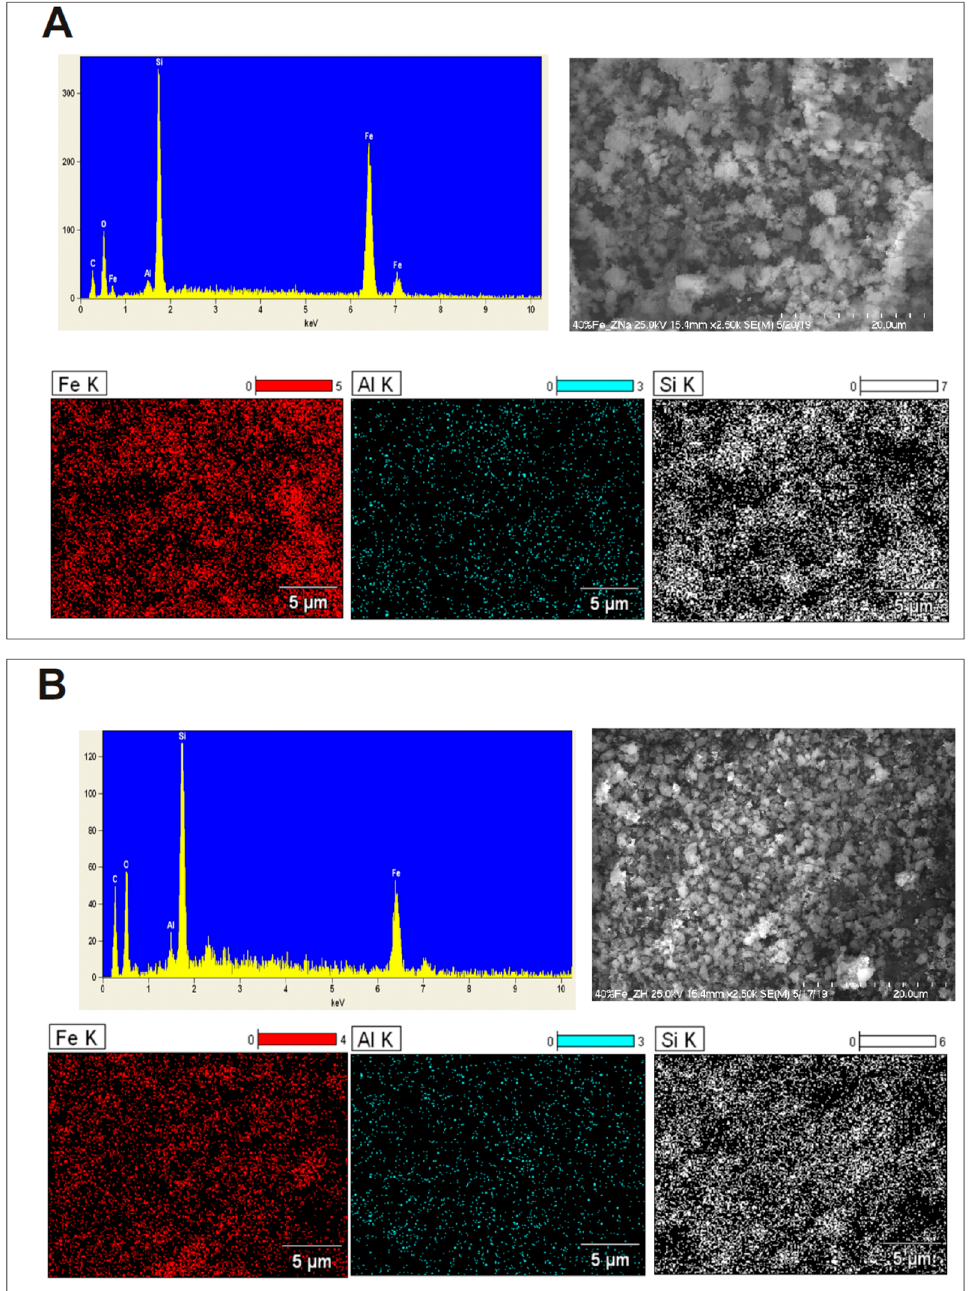
Figure 10. Scanning electron microscope images and EDX spectra collected for the investigated ( A ) 40%Fe/zeolite- β -Na and ( B ) 40%Fe/zeolite- β -H catalysts. The SEM images collected for the 40%Fe / Al 2 O 3 -Cr 2 O 3 (2:1) supported catalyst (results not